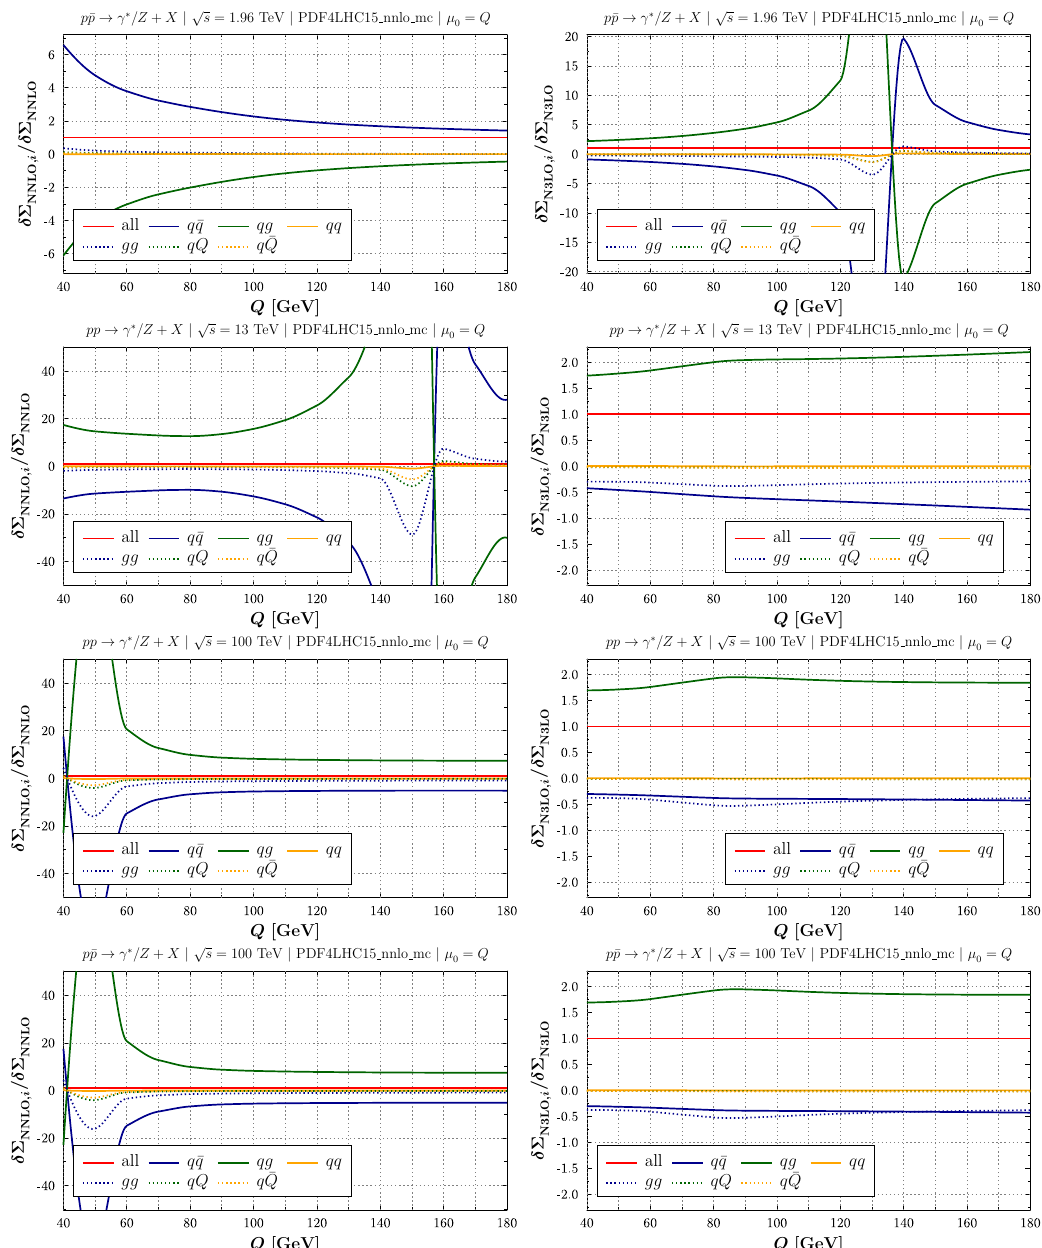
Figure 9 . Individual channels contributing to the invariant mass distribution for the production of an e + e − pair at different colliders normalized to the total correction at NNLO (left panels) and N 3 LO (right